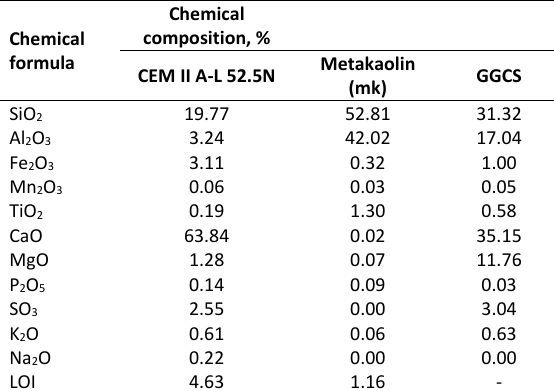
Table 2 . Chemical composition of cement, metakaolin and GGCS